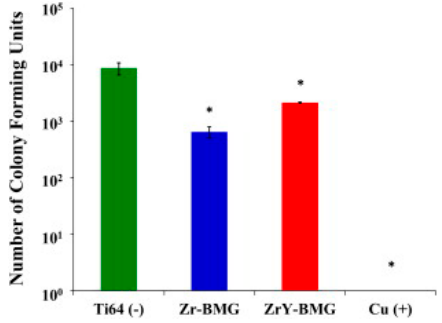
Figure 3. Growth of E. coli on exposure to Ti-6Al-4V, Zr 55 Al 10 Ni 5 Cu 30 BMG, (Zr 55 Al 10 Ni 5 Cu 30 BMG) 99 Y 1 and pure copper after 4 h